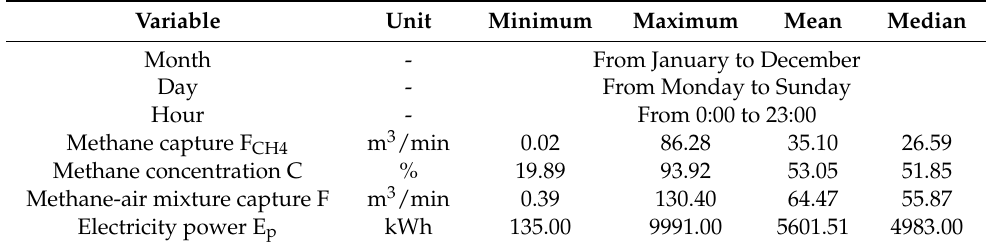
Table 3. Basic statistical parameters of variables.